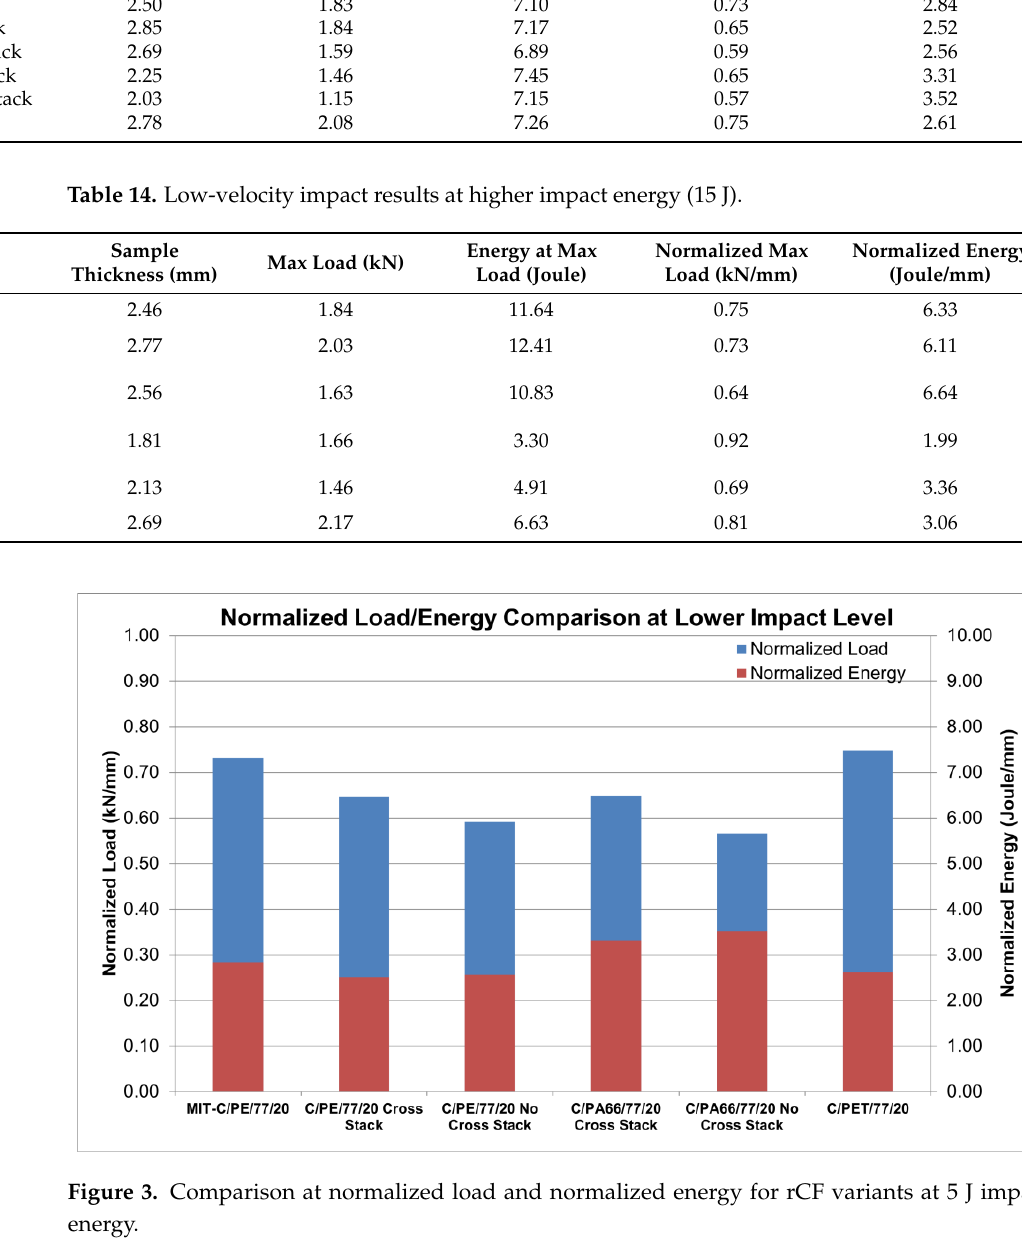
Table 14. Low-velocity impact results at higher impact energy (15 J).